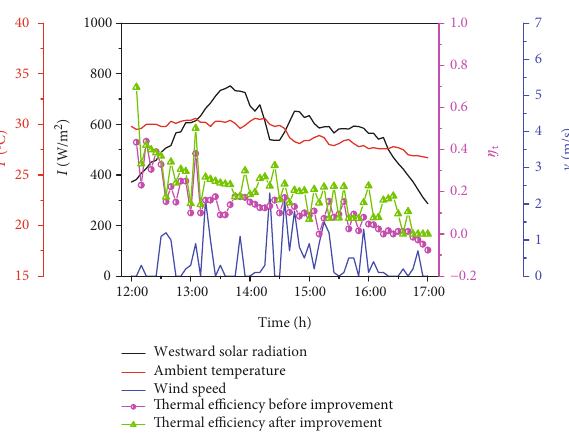
Figure 10: The work fl ow of GMM.